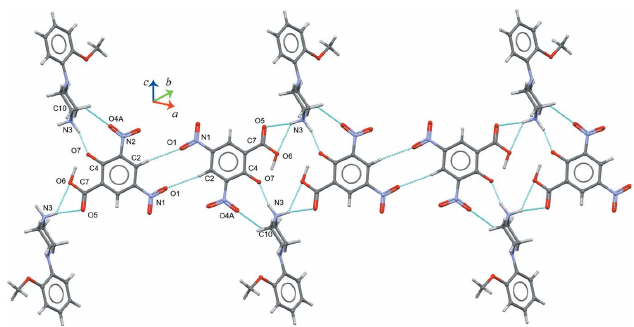
Figure 5 Part of the crystal structure of (I) showing the layered molecular